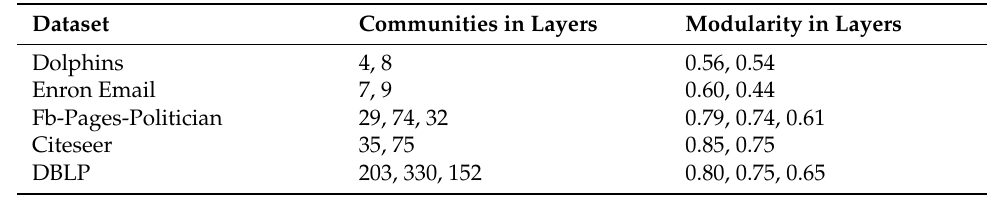
Figure 4. Results of modularity comparison of HCD algorithm with Infomap and Louvain algorithms.